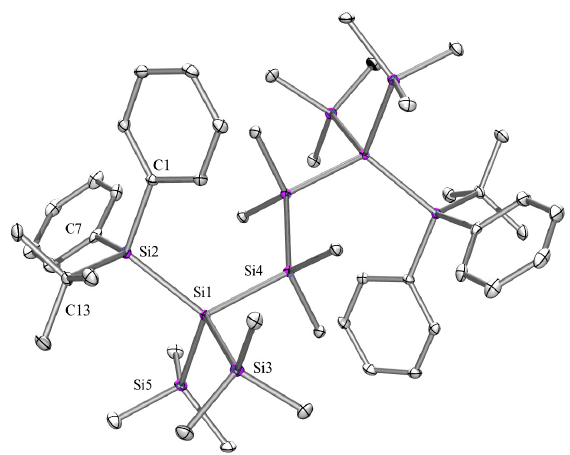
Figure 15. Crystal structure of 17 . Thermal ellipsoids are represented at the 30% level and hydrogen atoms have been omitted for clarity (bond lengths in Å, angles in deg). Si(1)-Si(5) 2.3726(9), Si(1)-Si(3) 2.3806(9), Si(1)-Si(2) 2.4011(8), Si(1)-Si(4) 2.4184(9), Si(2)-C(1) 1.887(2), Si(5)-Si(1)-Si(3) 105.73(3), Si(5)-Si(1)-Si(2) 107.99(3), Si(3)-Si(1)-Si(2) 114.99(3), Si(5)-Si(1)-Si(4) 107.83(3), Si(3)-Si(1)-Si(4) 100.65(3), Si(2)-Si(1)-Si(4) 118.74(3).